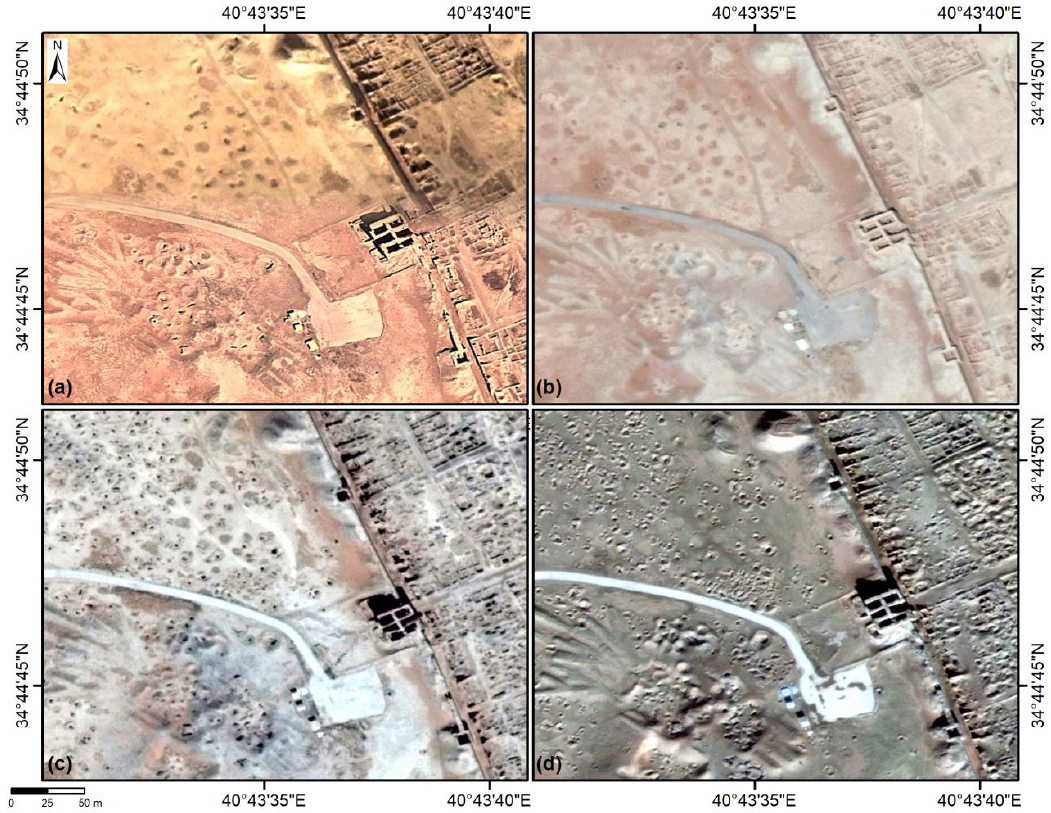
Figure 20. Multi-temporal comparison of ( a ) QuickBird (12 December 2007, upper part) and GeoEye-1 (7 April 2011, lower part), ( b ) WorldView-2 (4 August 2011), ( c ) WorldView-2 (11 April 2015) and ( d ) GeoEye-1 (23 January 2017) images over the looted areas beyond the walls of Dura Europos (Syria) highlights the effect of temporal granularity of VHR optical satellite images, lighting and visibility of looting features on interpretation of looting timing (i.e., old and new looting). Precise location is reported in Figure 14. Google Earth images © 2019 Maxar Technologies.